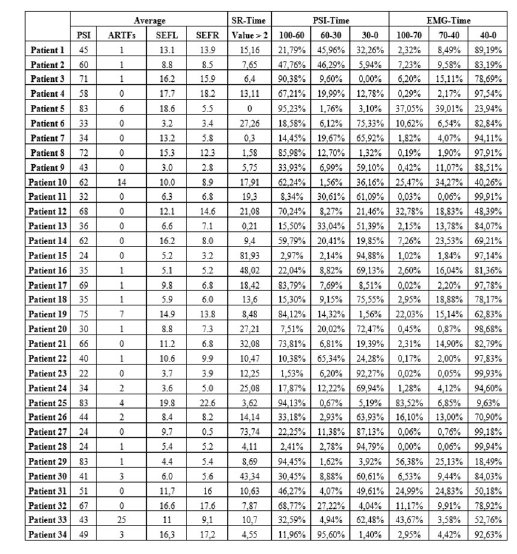
table. D3 plasmatic level of CD34+/CD133+ EPC (46 [26-121] vs. 89 [42-143], p=0.22) or CD34+/CD133+/VEGFR2+ EPC (8 [3-31] vs. 18 [1- 46], p=0.47] (figure), maximal variation of CD34+/CD133+ EPC (9 [0- 48] vs. 30 [0-103], p=0.48) or CD34+/CD133+/VEGFR2+ EPC (4 [0-73]